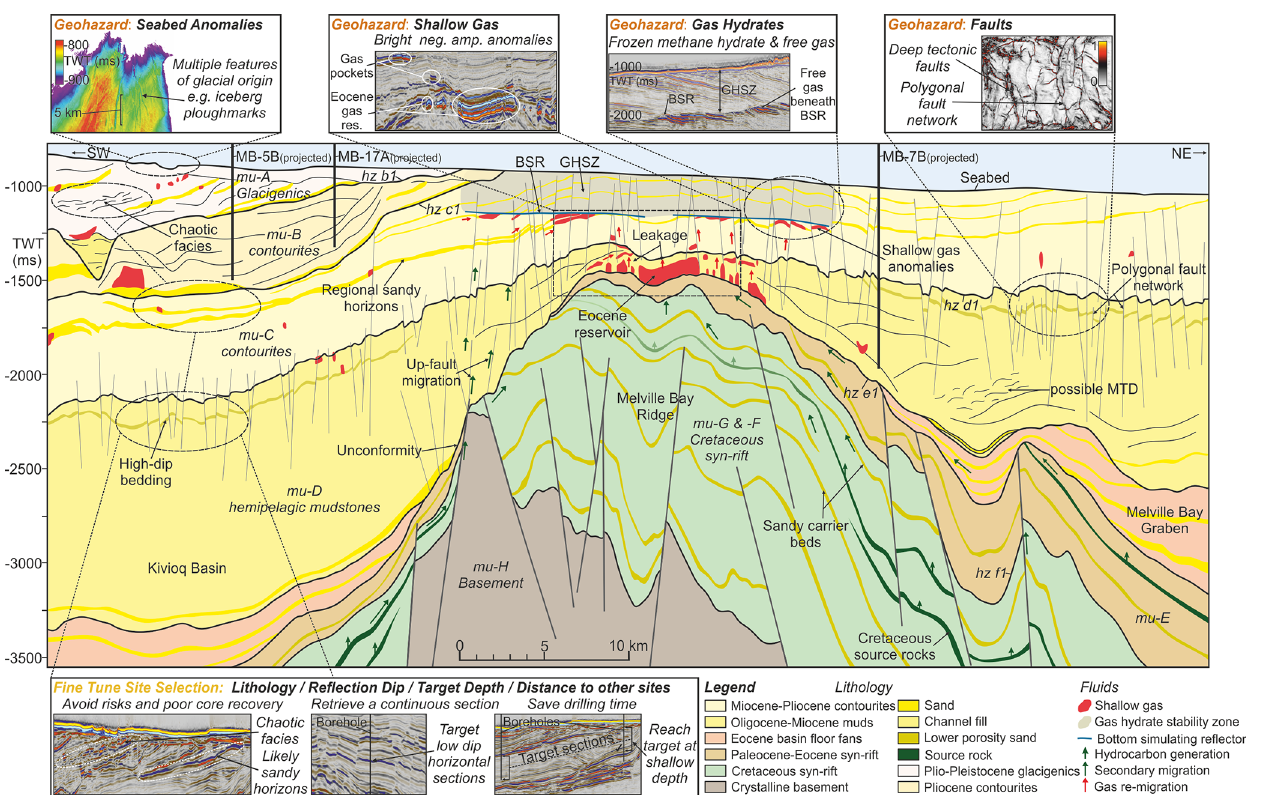
Figure 15. A schematic summary of the structure, stratigraphy, geohazards, and fluid flow history that has been analysed and used within the process of site selection for IODP Proposal 909. Key features related to the elements of the geohazard assessment workflow are shown, including the location of hydrocarbon fluids, sandy lithologies, faults, and the potential source rock horizons and possible fluid migration pathways. The surrounding thumbnails show how these features were analysed and considered within the geohazard assessment workflow. Highlighting the distribution of these features across the schematic aims to provide context on how these features fit together and interact within the subsurface. The understanding of this system, along with the distribution of potential geohazards, was crucial in the identification of viable stratigraphic targets and safe drill